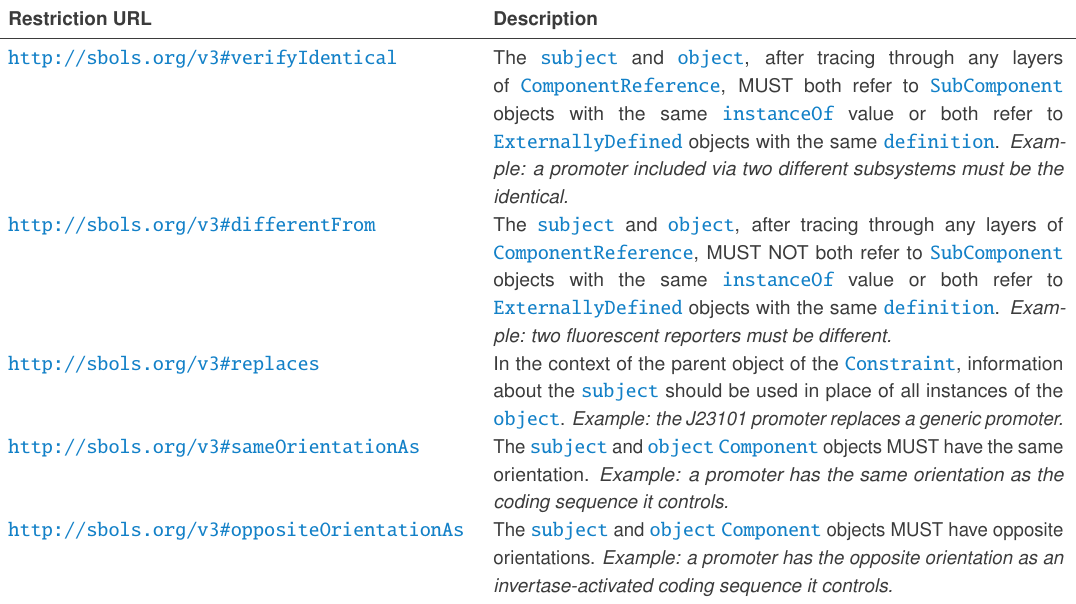
Table 8: RECOMMENDED URL s for expressing identity and orientation with the restriction